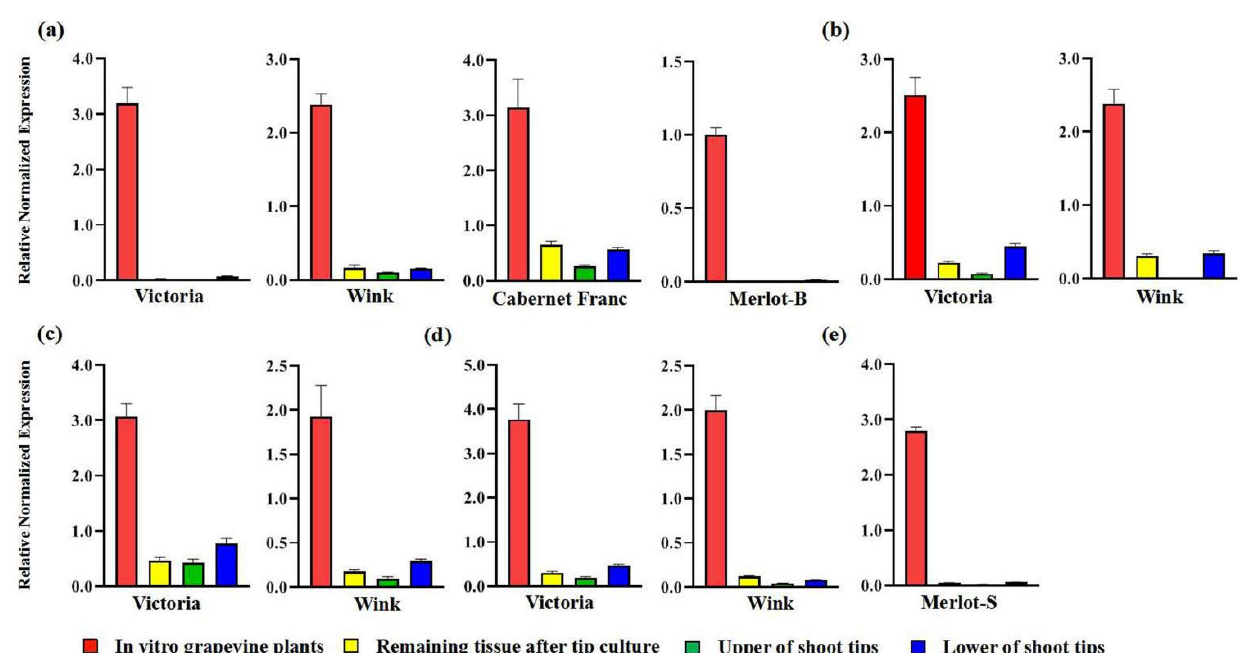
Figure 2. The relative concentrations of ( a ) GRSPaV, ( b ) GRLaV-3, ( c ) GFkV, ( d ) GRLaV-2, and ( e ) GRLaV-1 in different materials of different grapevine cultivars.